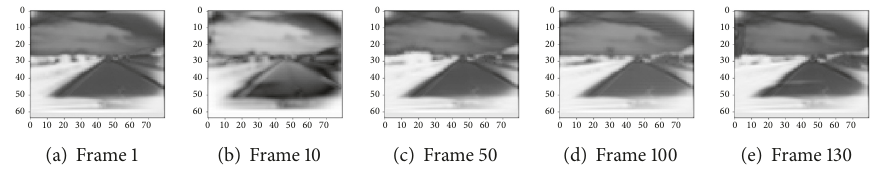
Figure 16: Predicted images after training (Construction site).